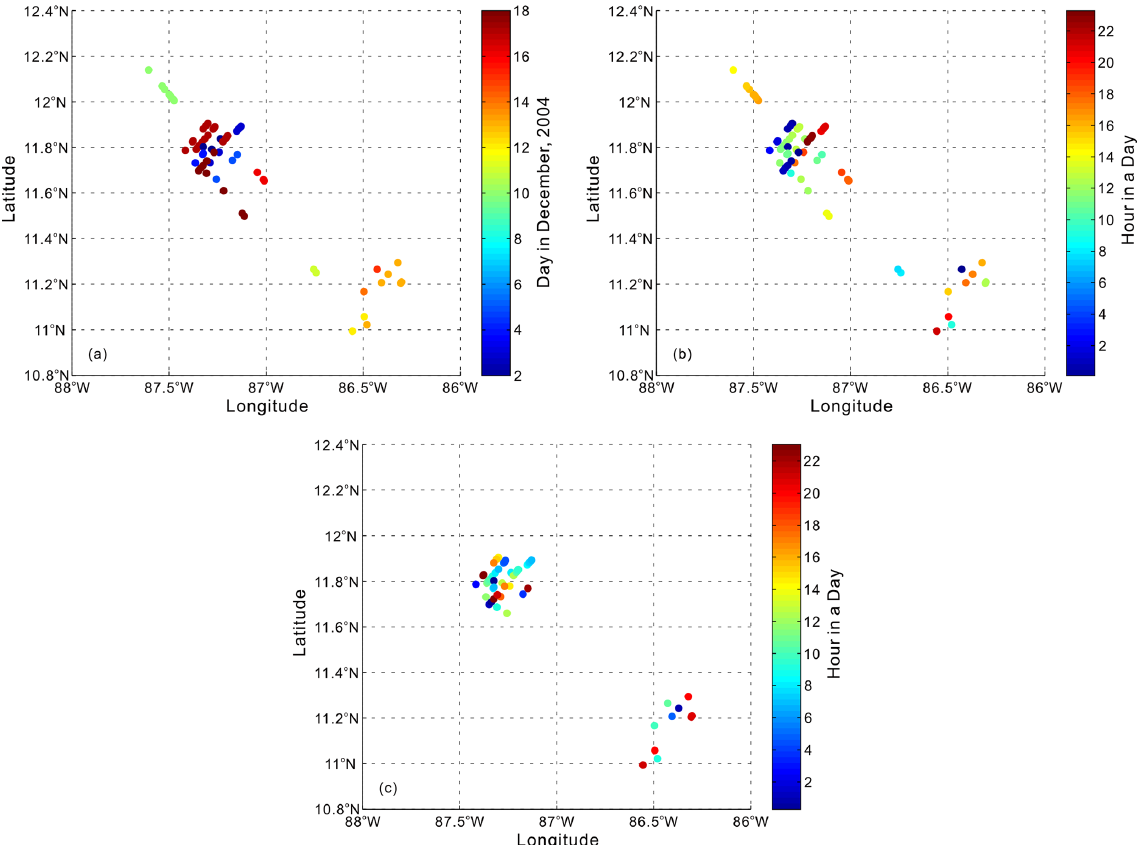
Figure 5. (a) The time at which the mode-2 ISWs observed in the study area appeared in days. (b) The time at which the mode-2 ISWs observed in the study area appeared in hours. (c) Tracing back the time (in hours) at which internal solitary waves appeared at the continental shelf break in the study